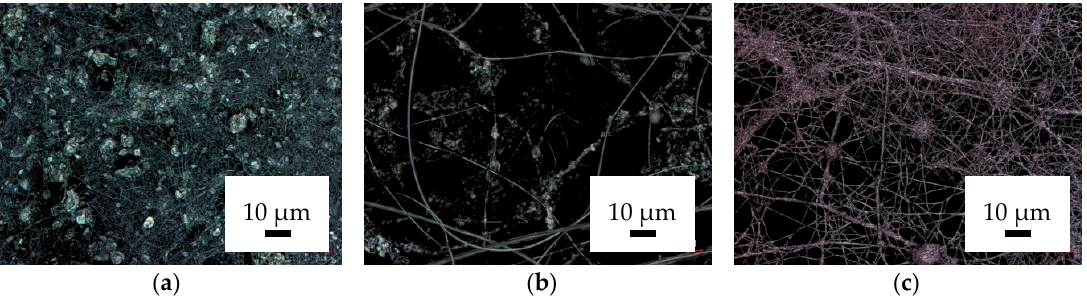
Figure 1. CLSM images of different nanofiber mats: ( a ) PAN/graphite; ( b ) PAN on top of PAN/graphite; ( c ) PAN/TiO 2 /dye.